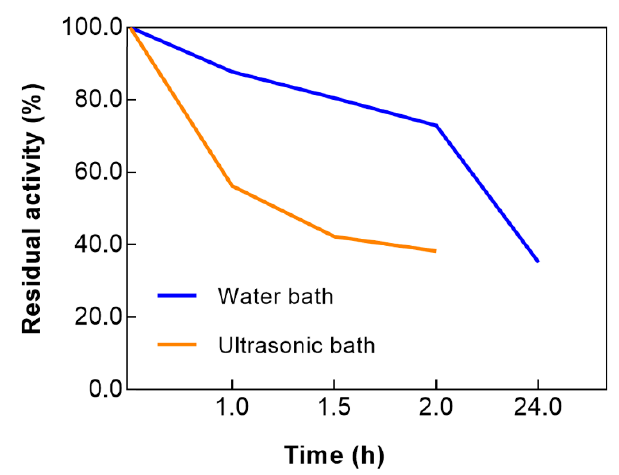
Figure 1. Residual enzyme activity of laccase incubated in a water bath (blue line) and in an ultrasonic bath (orange line) in acetate buffer, pH 4 at 25 °C.